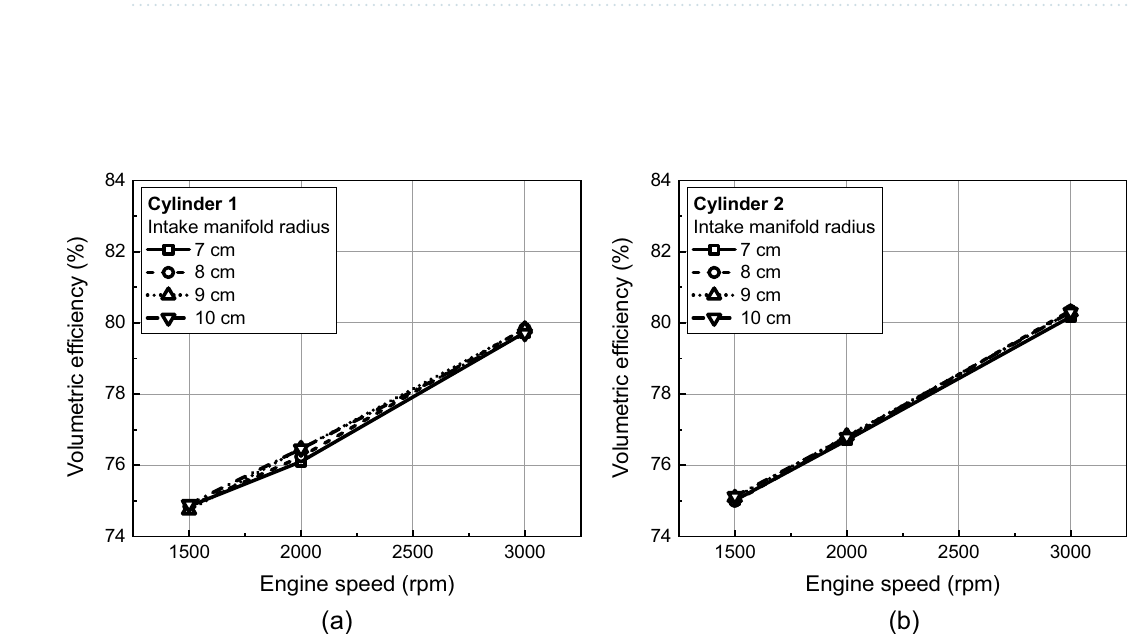
Figure 27. Volumetric efficiency for different intake manifold curve radius at ( a ) cylinder 1 and ( b ) cylinder